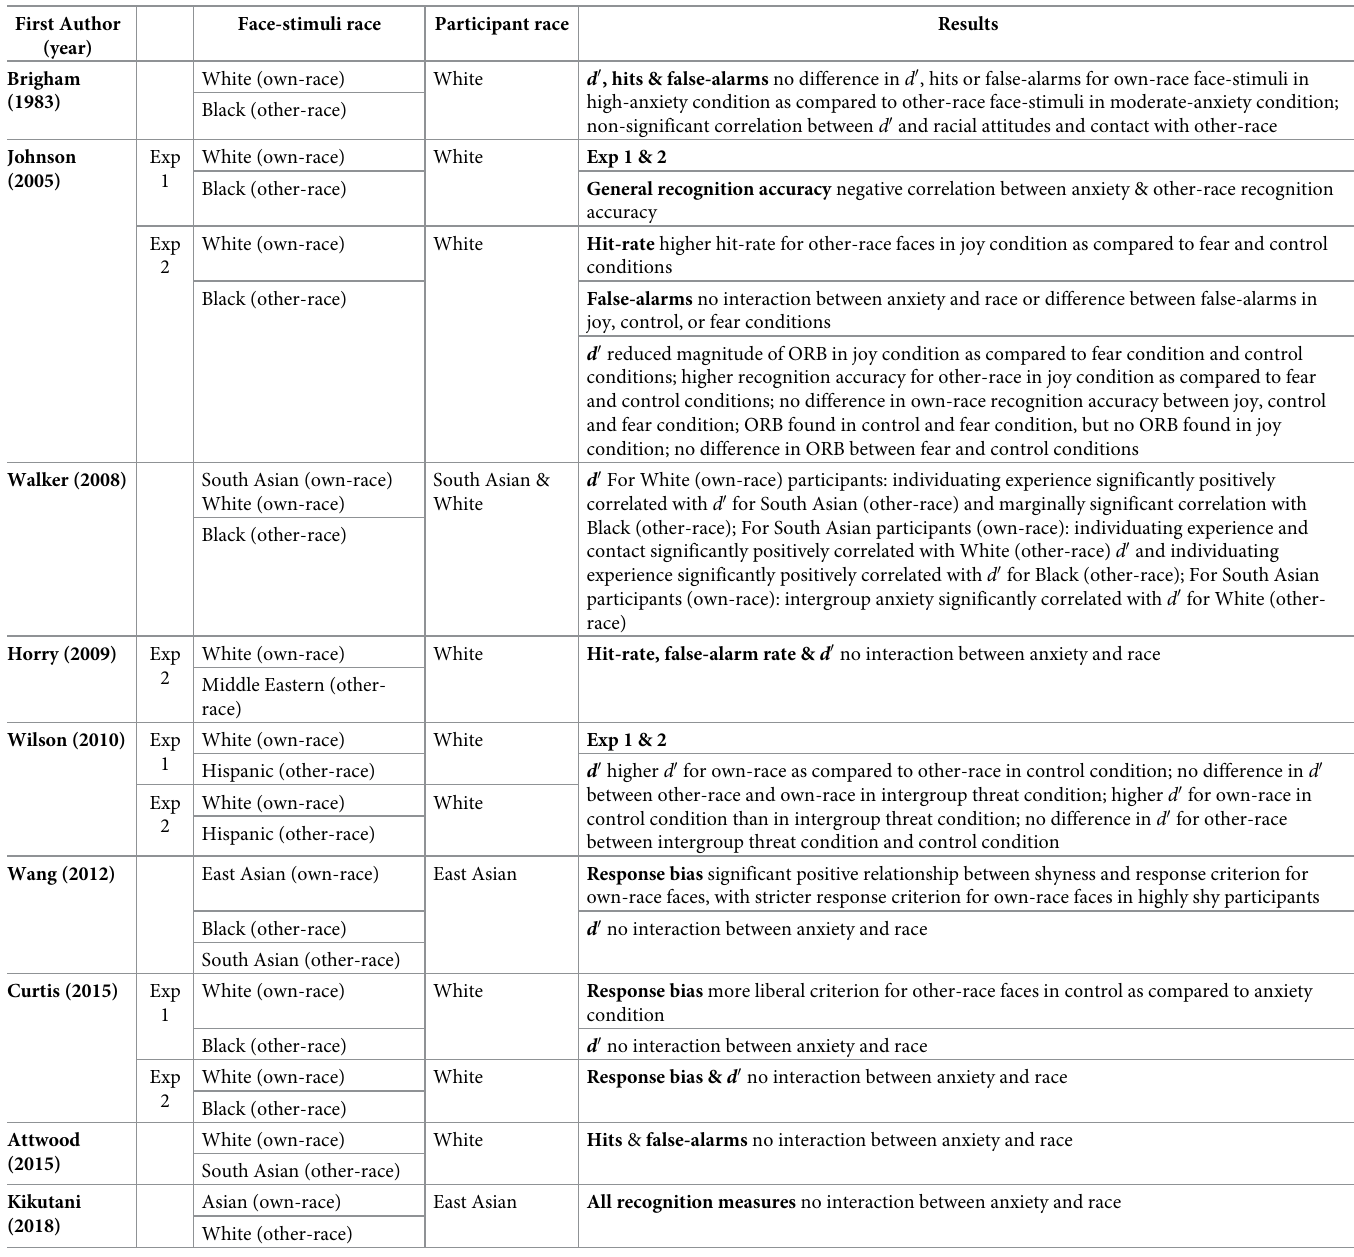
Table 4. Race of participant and stimuli of studies and results of studies examining the interaction between anxiety and race. First Author